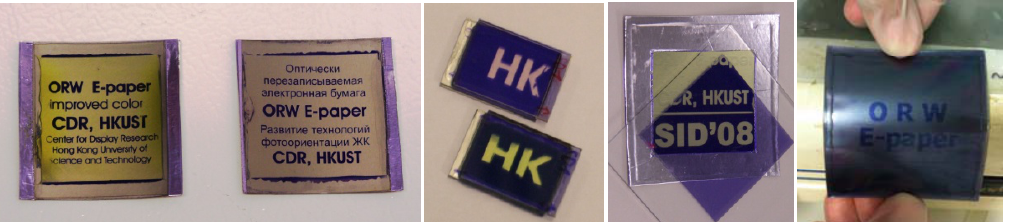
Figure 5. Images of optically rewritable (ORW) LC display